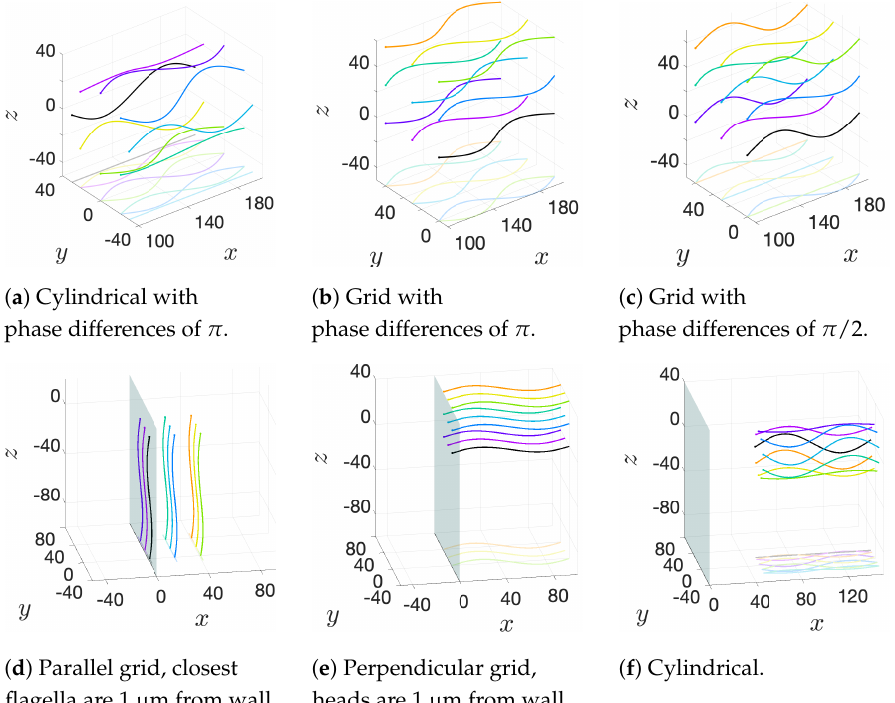
( b ) Grid with phase differences of π .